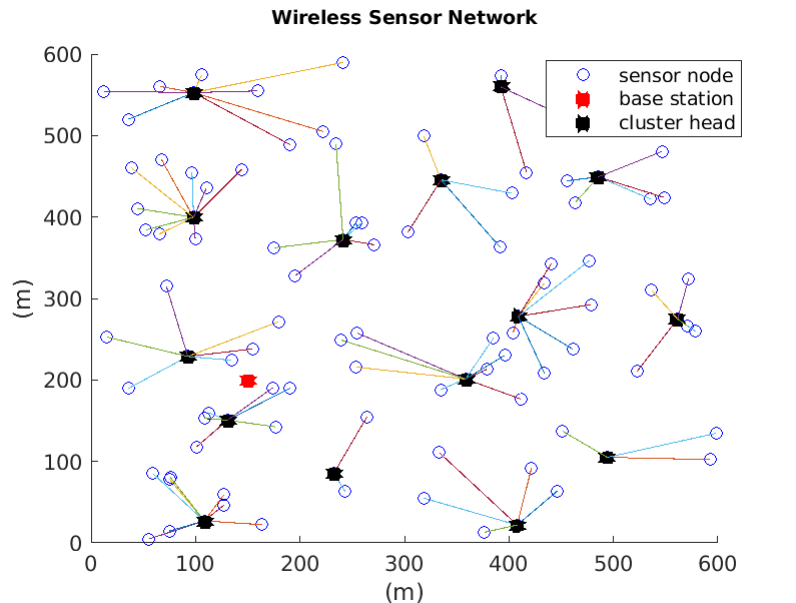
Figure 6. The network